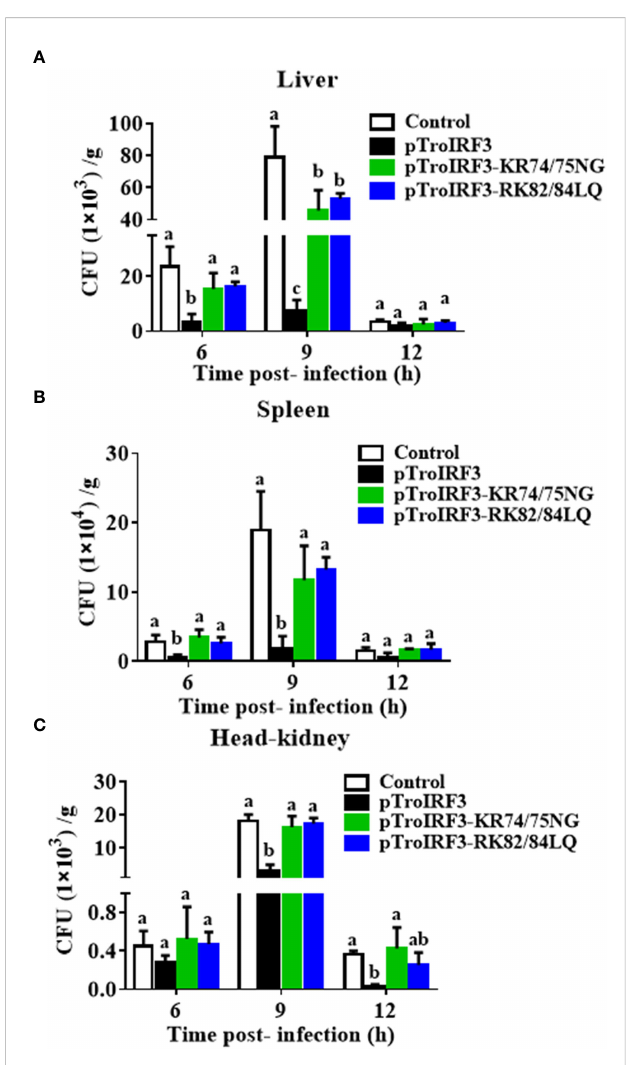
FIGURE 6 The function of NLS in antibacterial responses regulated by TroIRF3. T. ovatus were administered with PBS (control), pTroIRF3, pTroIRF3-KR74/ 75NG, or pTroIRF3-RK82/84LQ for 5 days, then injected intraperitoneally with V. harveyi , and the number of bacteria in the liver (A) , spleen (B) , and head-kidney (C) at different time points were quanti fi ed using the plate counting method. Data are expressed as means ± SD (N = 3). N, the number of fi sh used at each time point per group. Signi fi cant differences ( P < 0.05) are indicated by different letters, and no signi fi cant differences are indicated by the same